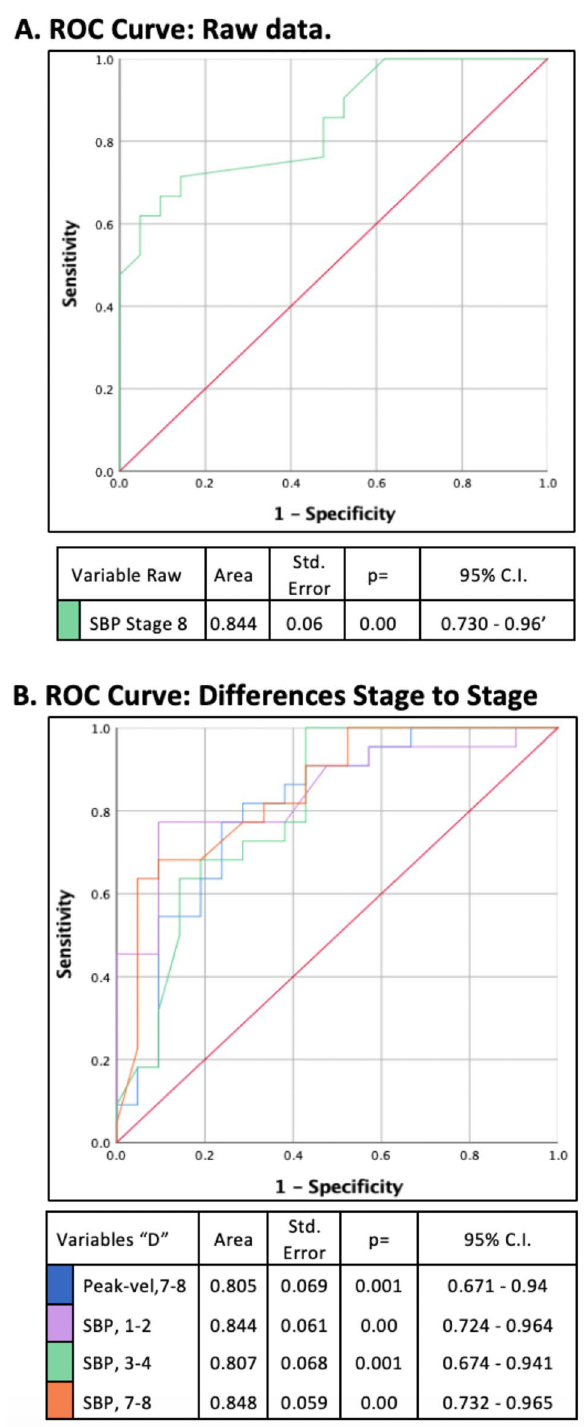
Figure 3. ROC curves of the variables resulting in an area under the curve > 0.70 in a given stage. ( A ) Raw data, (SBP), ( B ) differences stage to stage, (SBP, and Peak-vel) in different stages. SBP systolic blood pressure, Peak-vel . systolic velocity of the